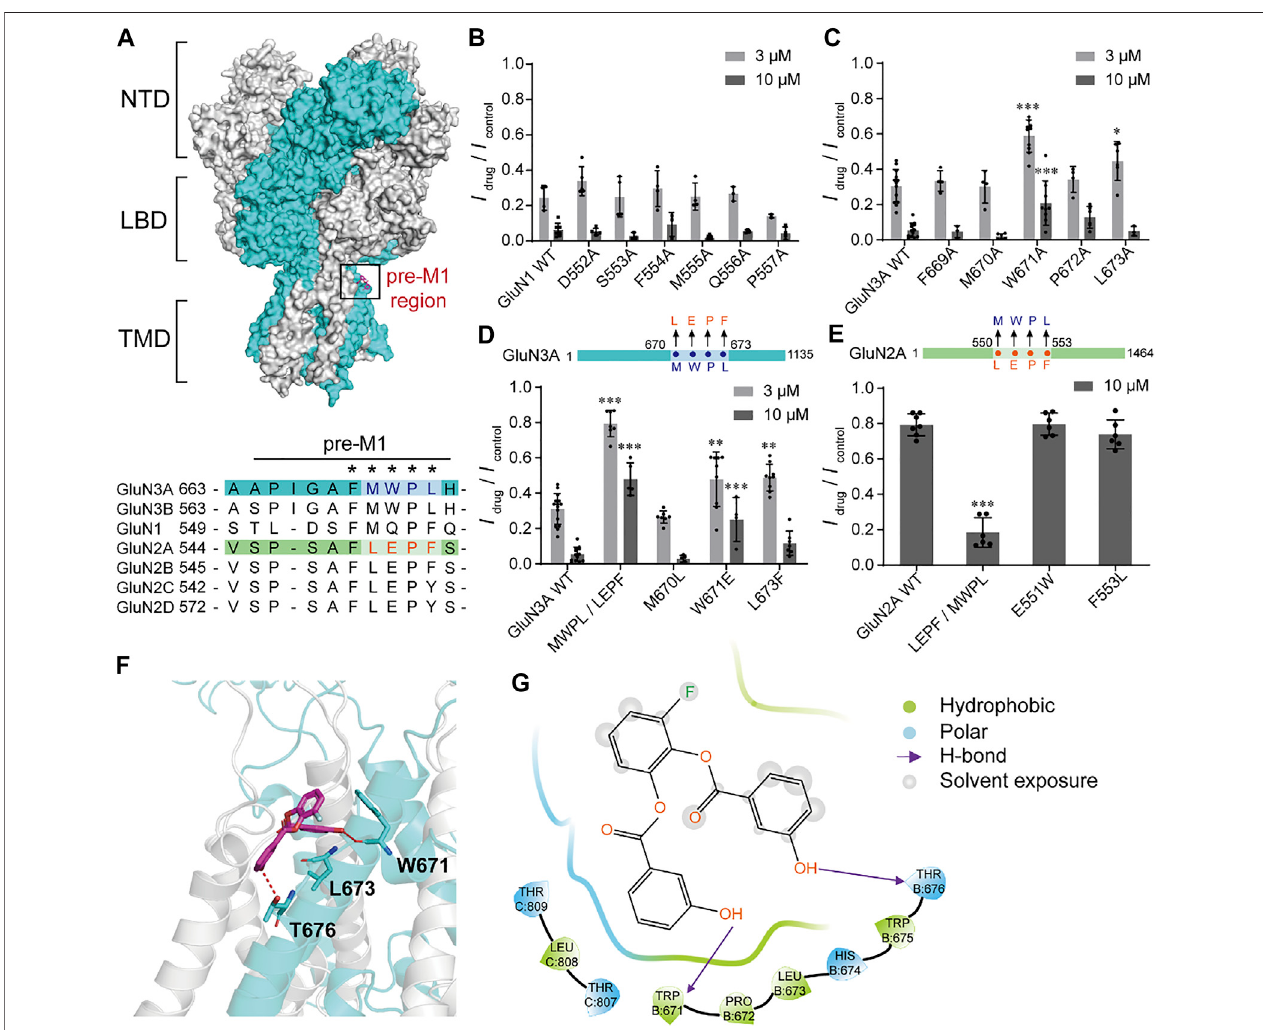
FIGURE 6| Critical residuesfor WZB117inhibition. (A) Homology model of the GluN1/GluN3A structure based on the structures of GluN1/GluN2B receptor (PDB ID:6WHS)andtheLBDofGluN3Asubunit(PDBID:2RC7).GluN1andGluN3Asubunitsareshowningrayandcyan,respectively(NTD:theN-terminaldomain;LBD:the ligand binding domain; TMD: thetransmembranedomain). Theblackbox indicates the pre-M1 region. The bottom panelshows thesequencealignmentofpre-M1 in all NMDAR subunits. Residues marked with an asterisk were selected for mutagenesis and whole-cell patch-clamp recordings. (B and C) Scanning mutagenesis across the pre-M1 region of GluN1 (B) and GluN3A (C) subunits. (D and E) Inhibition of WZB117 after amino acid substitutions in the pre-M1 regions between GluN3A (D) and GluN2A (E) subunits. (F) Putativebindingmode ofWZB117.Thecompound isshownasmagentasticks,andkeyresidues areshown ascyansticks.Hydrogen bondsareshownasareddashedline. (G) 2DdiagramoftheinteractionsbetweencompoundsWZB117andGluN1/GluN3Areceptors.Allrecordingswerecarriedoutin transiently transfected CHO cells. Signi fi cance was tested using one-way ANOVA; p p < 0.05, pp p < 0.01 and ppp p < 0.001.